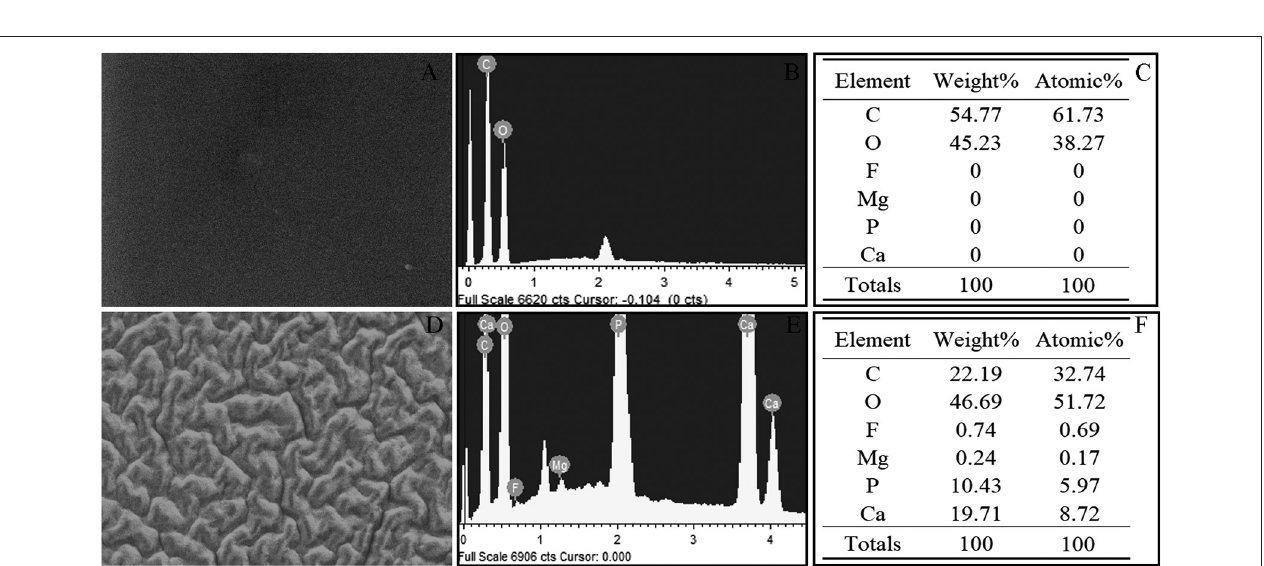
FIGURE 1 | Characteristics of the implanted IOL. Slit-lamp photographs (A–D) from the four patients, showing grayish white with a diffuse ground glass appearance on the anterior surface of the lens. (A–D) Obtained from case 1, 2, 3, 4. L-312 IOLs (E–G) showed a great quantity of vacuoles and US-860 UV (H) presented cerebriform under light microscopy (original magnification × 40). (E–H) Obtained from case 1, 2, 3, 4. Scanning electron micrographs obtained from case 1 (I,J) and case 4 (K,L) showed that the surface of L-312 IOL was smooth and US-860 UV IOL appeared as rough mountain. (I,K) Original magnification 500, (J,L) Original magnification 1,000.